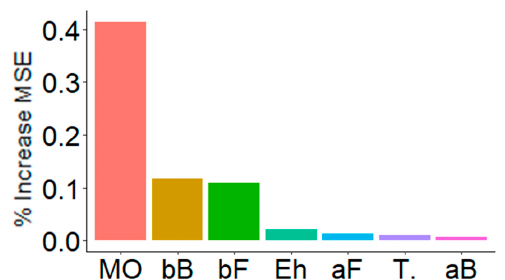
Figure 6. Key predictors of multifunctionality. These are the main predictors, according to decision trees (RandomForest) performed with 5000 iterations. The importance of these predictors is observed according to the increase of the % of MSE (mean square error). MO = organic matter related variables (41.5%), bB = Bacterial β -diversity (12.0%), bF = Fungal β -diversity (10.9%), Eh = redox potential (2.1%), aF = Fungal α -diversity (1.4%), T. = Temperature related variables (1.0%), and aB = Bacterial α -diversity (0.7%).